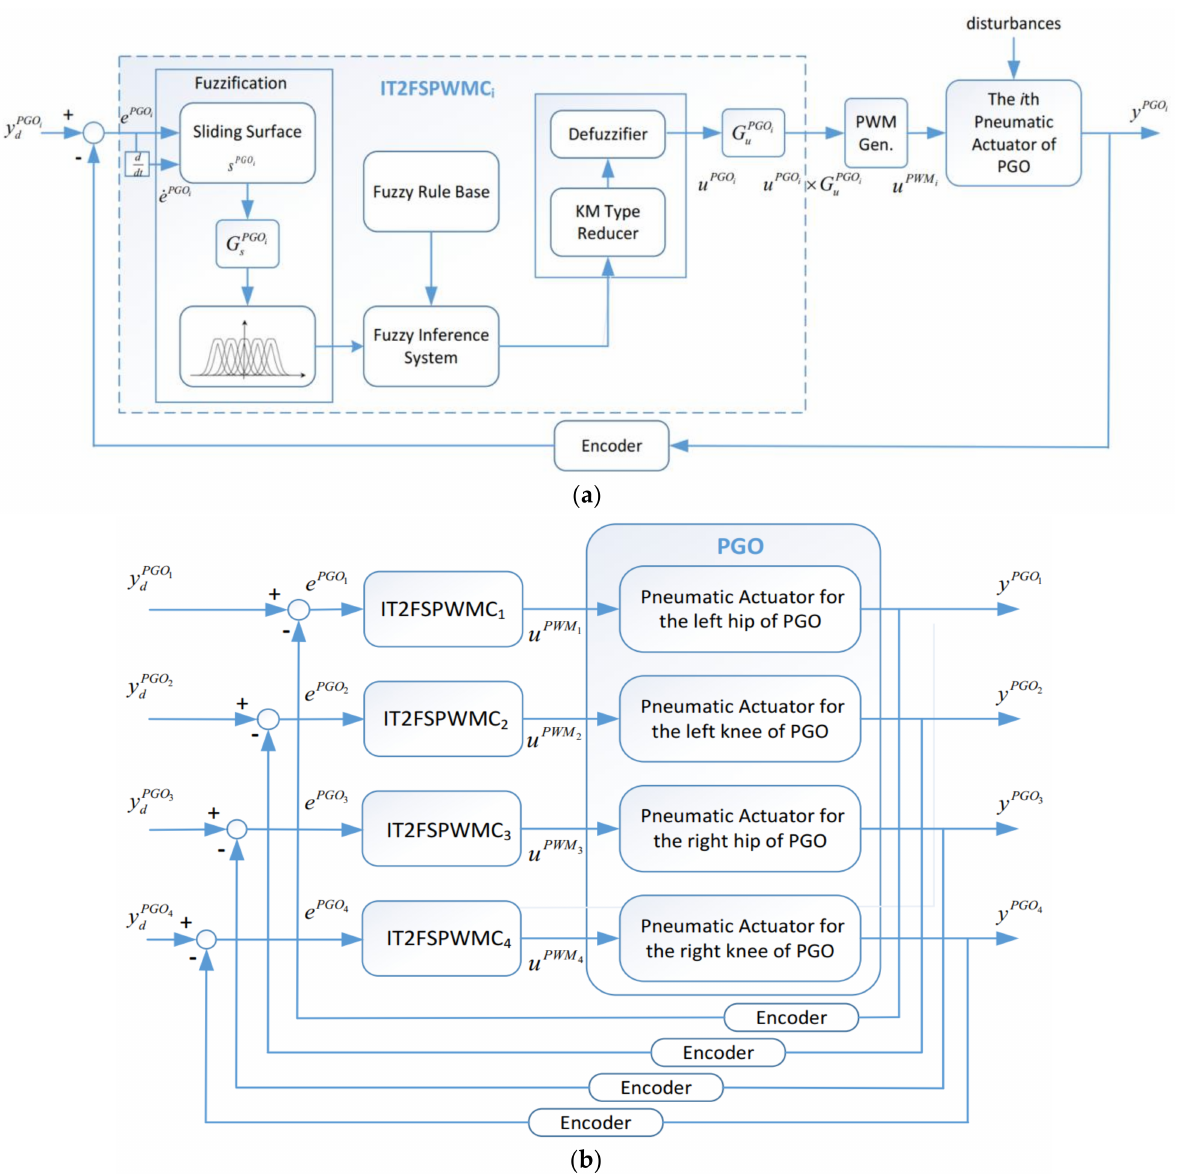
Figure 14. Block diagram of the interval type-2 fuzzy sliding pulse-width modulation control for the PGOS. ( a ) The i th interval type-2 fuzzy sliding pulse-width modulation controller; ( b ) the overall control block for the